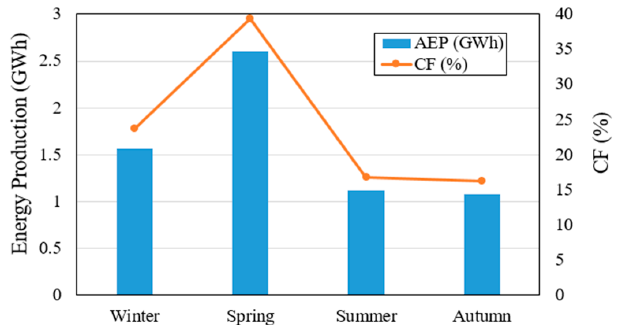
Figure 11. Season-wise energy production of best suited wind turbine for Deokjeok-do at optimum hub height.